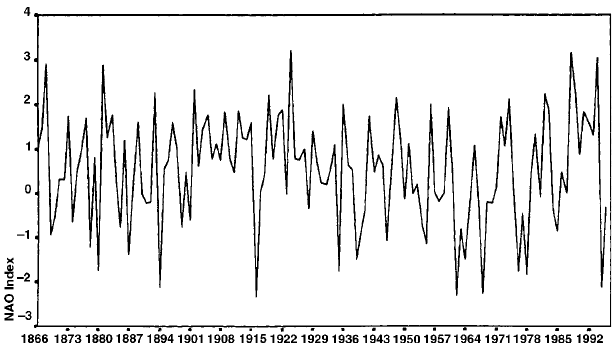
Fig. 1. Winter index of the North Atlantic Oscillation (1866–1997) based on the mean normalized pressure di(cid:128)erence between Gibraltar and Reykjavik